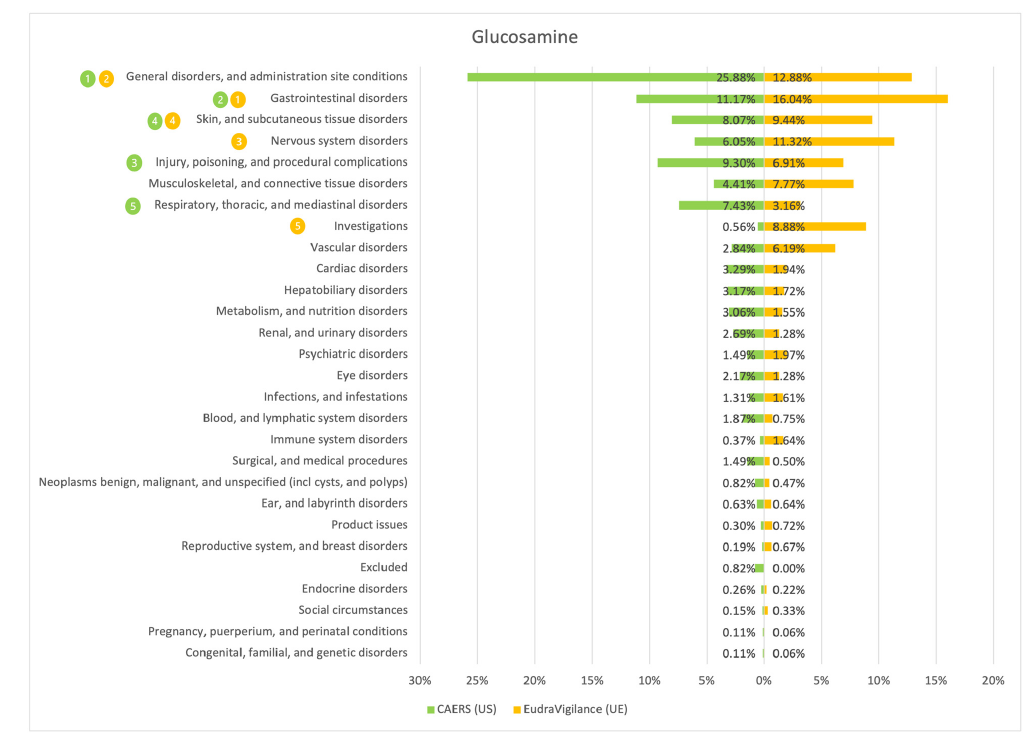
Figure 4. Summary of the frequency of reporting side effects of Glucosamine in the US and EU registers. Data marked in green refer to the CAERS (US) database and yellow to the EudraVigilance (UE) database. Numbers 1–5 present the most commonly reported categories of adverse effects in descending order.